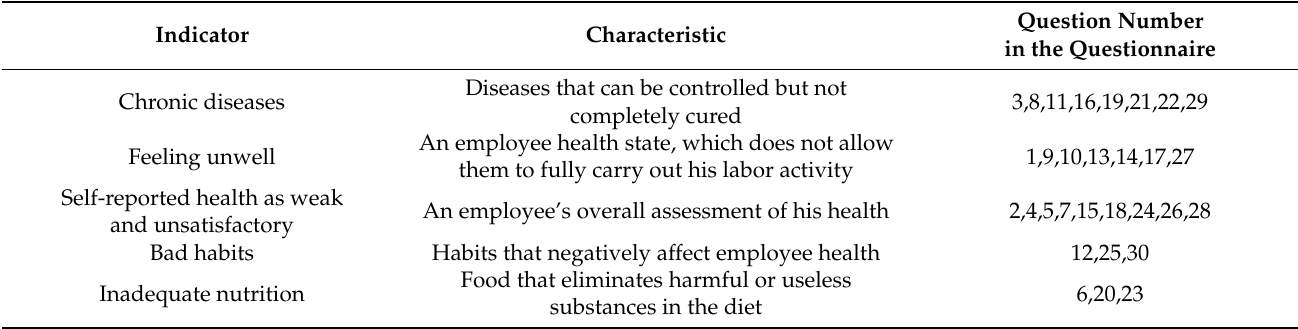
Table A2. Correspondence Between Questionnaire Questions and Summary Indicators to be Further Processed in the